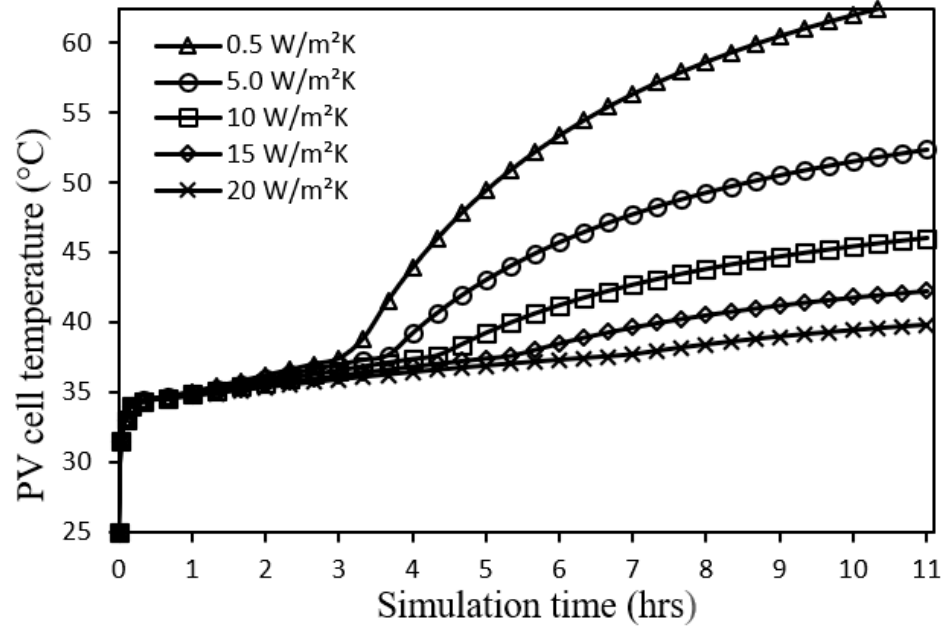
Figure 5. PV cell temperature profiles for different metal foam convective heat transfer coefficients.